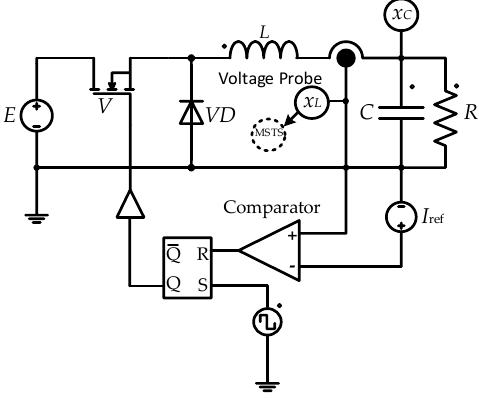
Figure 4. Buck converter with peak current control.